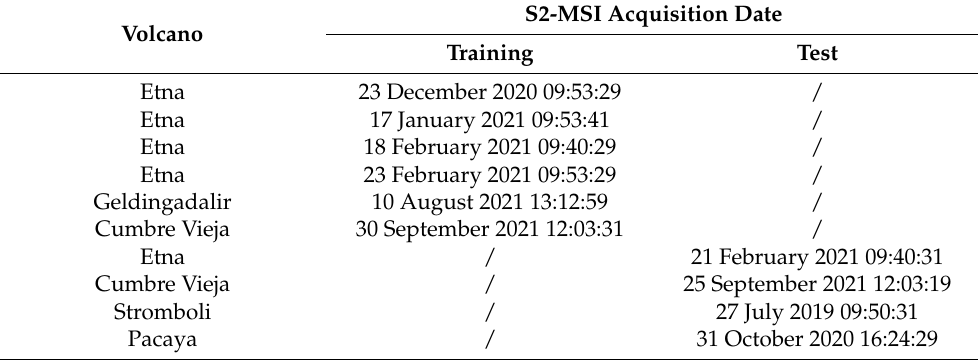
Table 2. Volcanoes investigated with the date of the images acquired from S2-MSI used for the RF models in the training and test